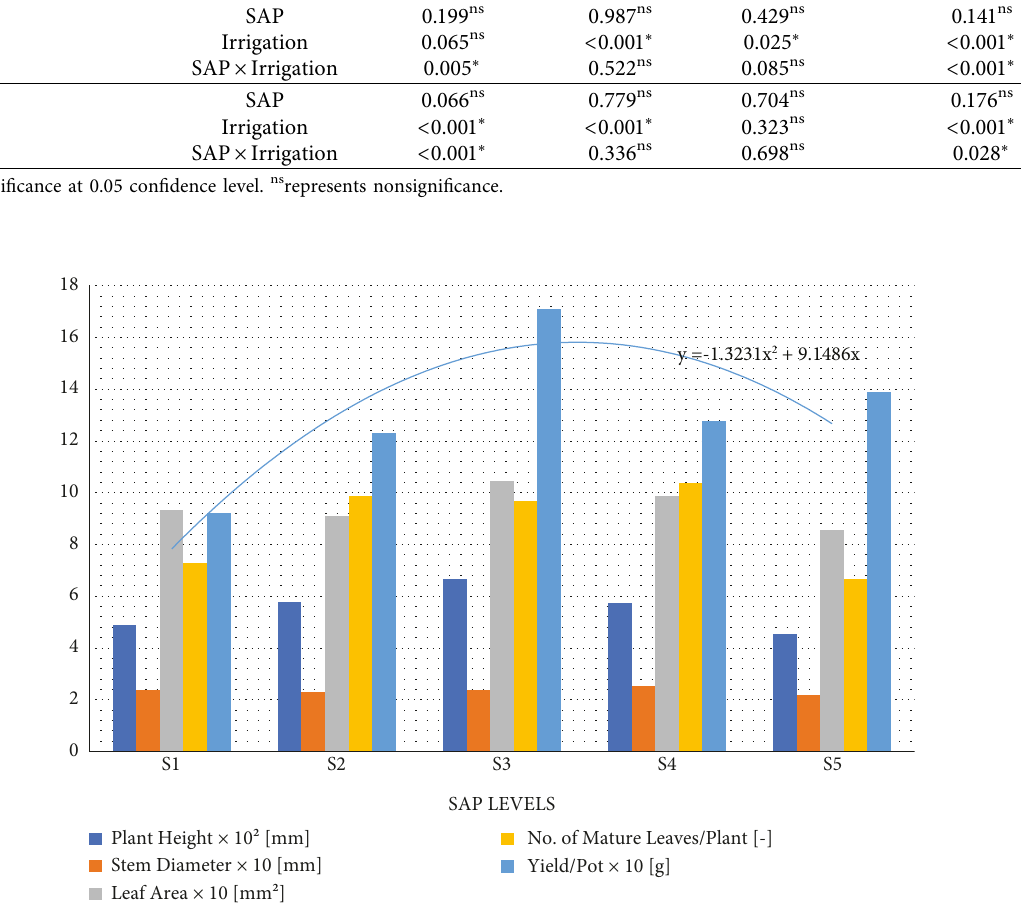
Figure 1: Effect of SAP on the growth and yield of cowpea.